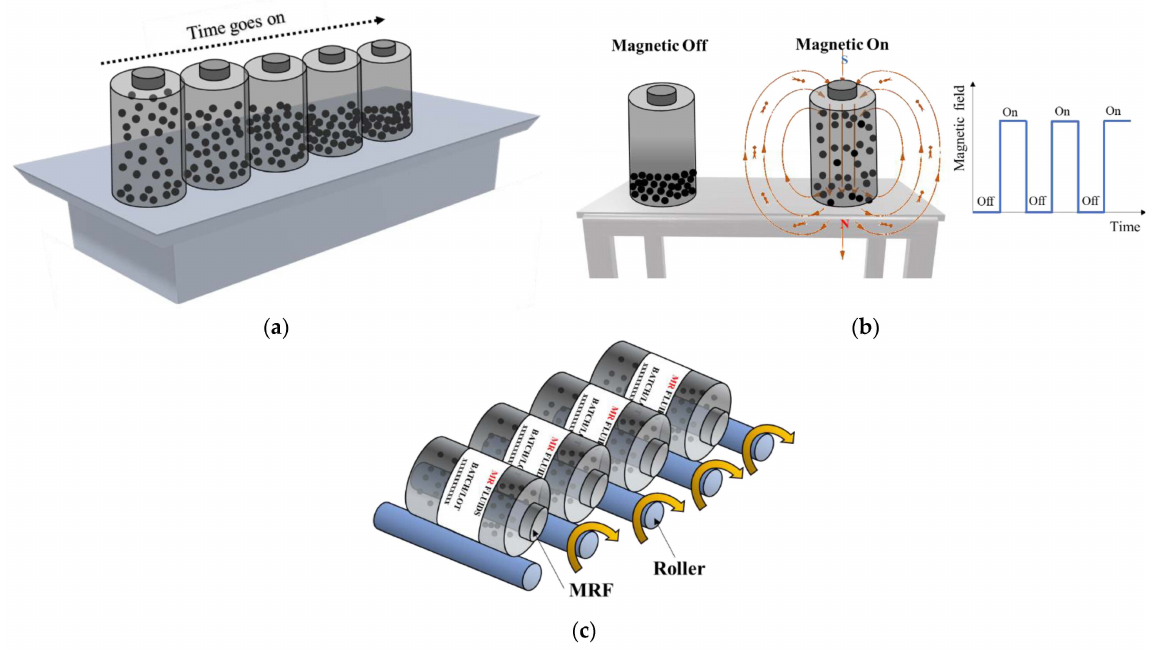
Figure 6. Conceptual methods for sedimentation reduction in bottle storage; ( a ) vertical standing on shelf, ( b ) vertical standing with on–off field state, and ( c ) horizontal position in rolling